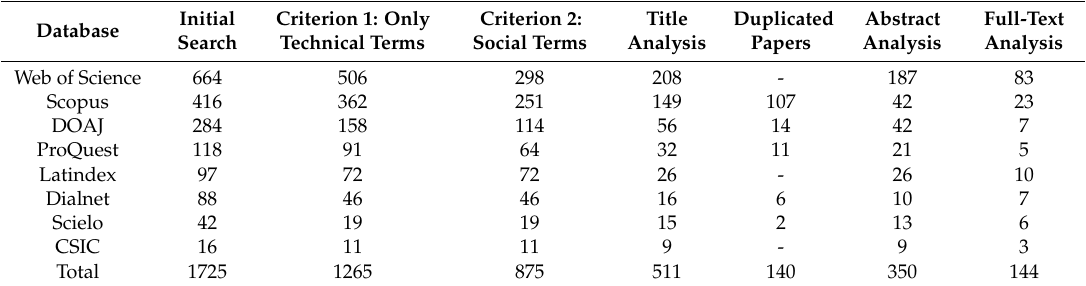
Table 2. Papers selected from database search analysis.